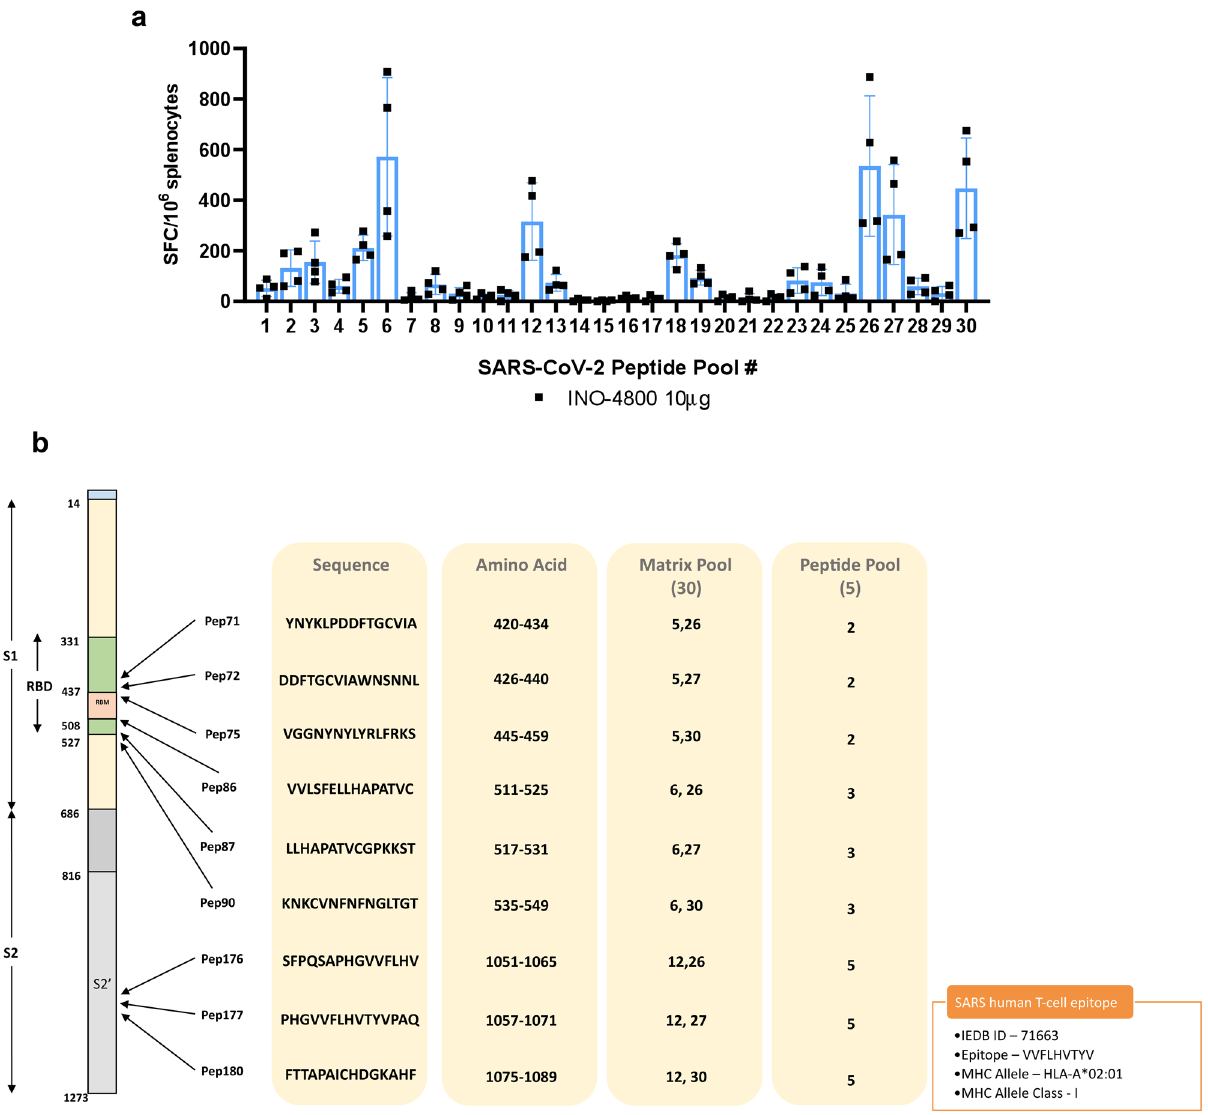
Fig. 9 T cell epitope mapping after INO-4800 administration to BALB/c mice. Splenocytes were stimulated for 20 h with SARS-CoV-2 peptide matrix pools. a T cell responses following stimulation with matrix mapping SARS-CoV-2 peptide pools. Bars represent the mean + SD of fi ve mice. b Map of the SARS-CoV-2 Spike protein and identi fi cation of immunodominant peptides in BALB/c mice. A known immunodominant SARS-CoV HLA-A2 epitope is included for